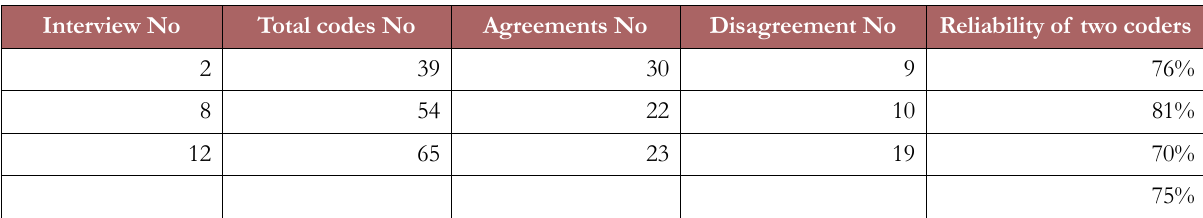
Table 1. Inter-coder